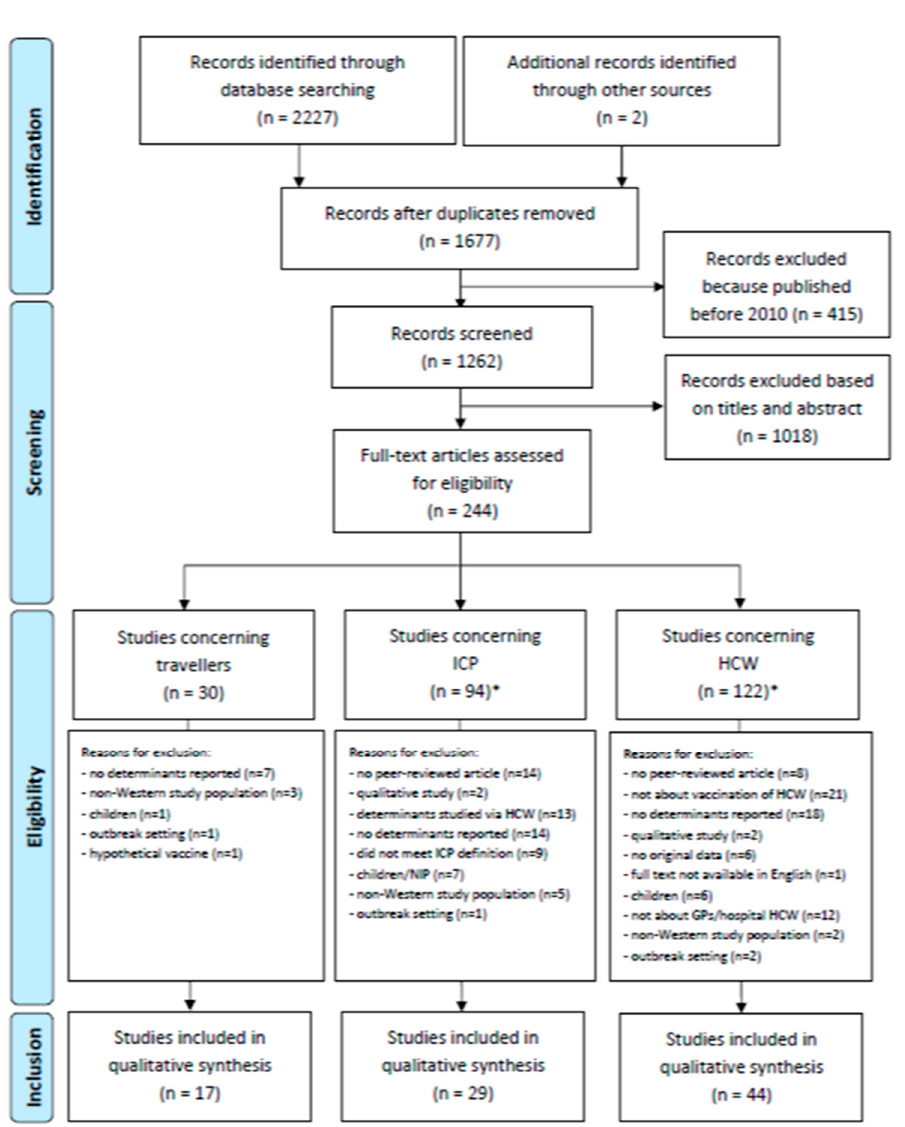
Figure 2. Flow diagram of study selection procedure. * n = 2 articles were included in both ICP and HCW.